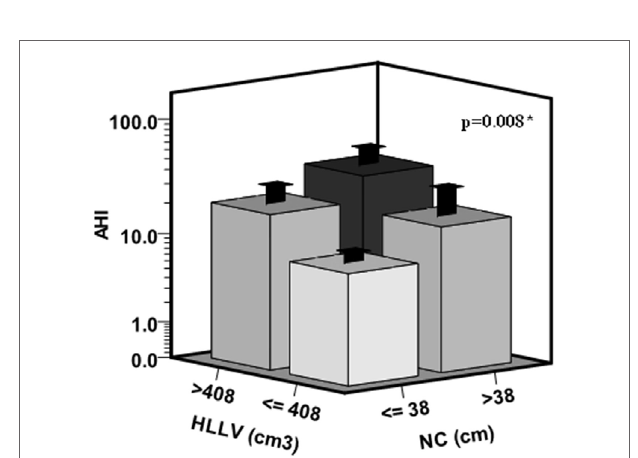
FigUre 2 | Hepatic left lobe volume (HLLV) (a) and neck circumference (b) average values for each class of obstructive sleep apnea–hypopnea syndrome (OSAHS). OSAHS severity is defined as mild for apnea/hypopnea index (AHI) ≥ 5 and < 15; moderate for AHI ≥ 15 and ≤ 30; and severe for AHI > 30. Error bars represent the 95% confidence interval of the mean. The variances of HLLV ( p = 0.08) and neck circumference ( p = 0.38) were not significantly different among OSAHS categories by the Levene’s test. *: p < 0.05 for linear trend by